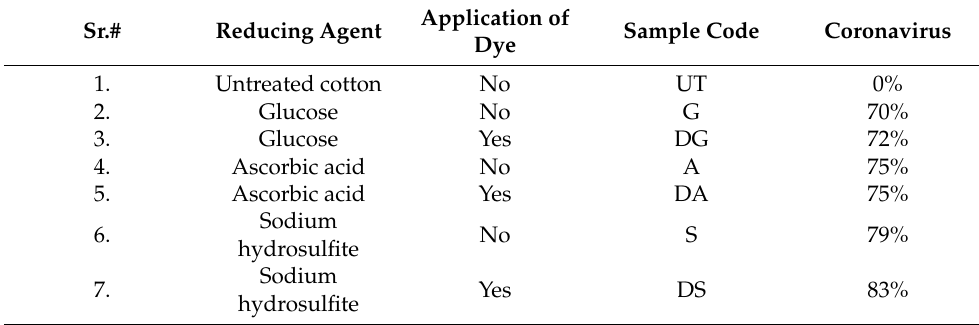
Figure 14. Reduction in viral infectivity titer ( a ) calculated from viral infectivity at a contact time of 0 and 60 min, ( b ) and percentage reduction. Table 9. Reduction percentages in antifungal